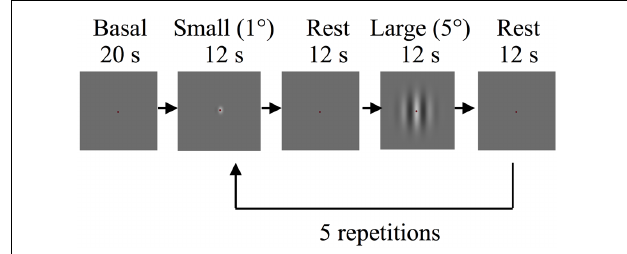
FIGURE 1 | Schematic depiction of the experimental procedure of the main functional magnetic resonance imaging (fMRI)